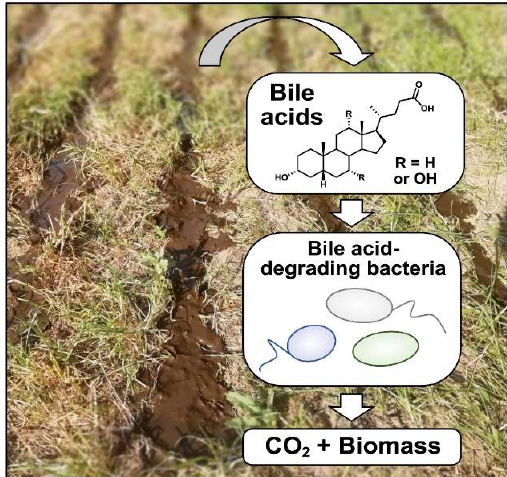
Figure 1. Manure fertilizer on agricultural fields as a source for bile salts, which can be used as a carbon and energy source by heterotrophic bacteria. carbon and energy source by heterotrophic